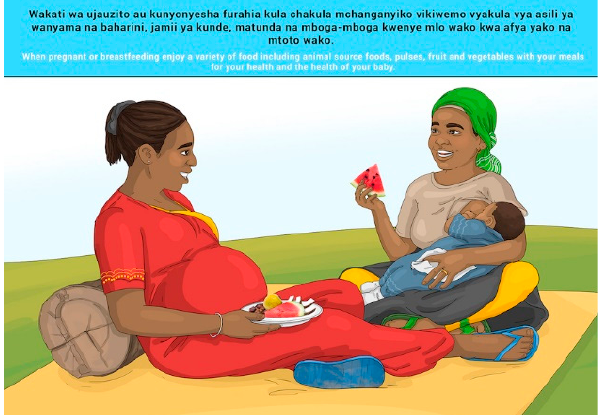
Figure 10. When pregnant or breastfeeding enjoy a variety of food including animal source foods, pulses, fruit and vegetables with your meals for your health and the health of your baby.